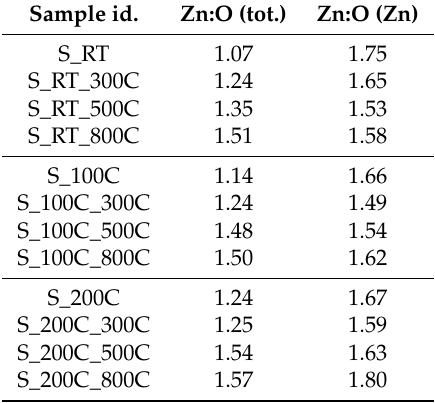
Table 6. The estimated ratio of Zn to O atoms. Sample